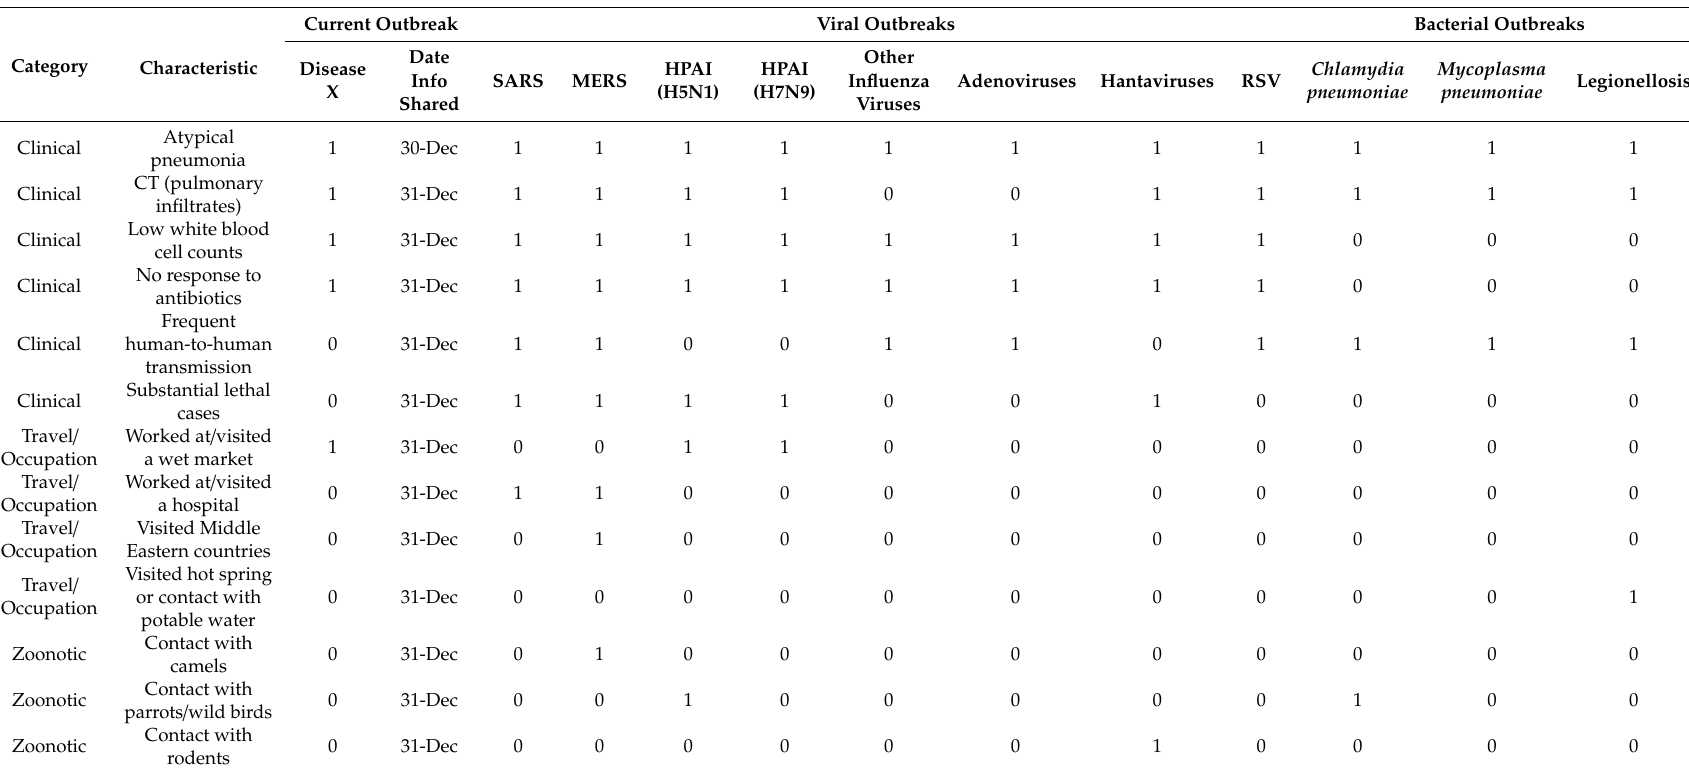
Table 1. Observed characteristics of the current outbreak in Wuhan, China, as well as general characteristics of outbreaks driven by previously known pneumonia-causing